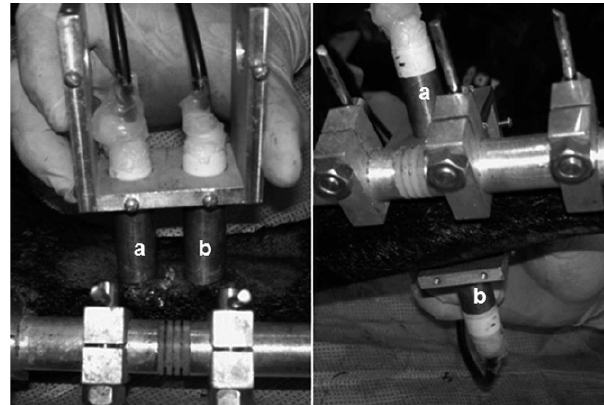
Figure 2 - Ultrasound velocity measurement, showing the ultrasound transducers (a and b) parallel to each other for the axial modality (left) and in opposition to each other for the transverse modality